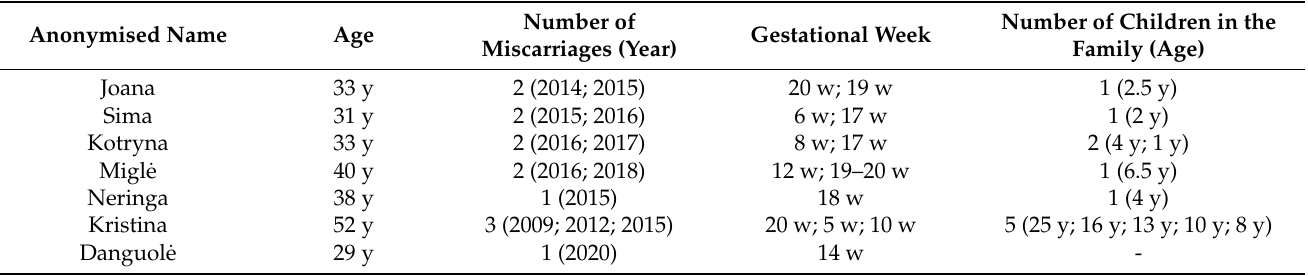
Table 1. Demographic characteristics of a study